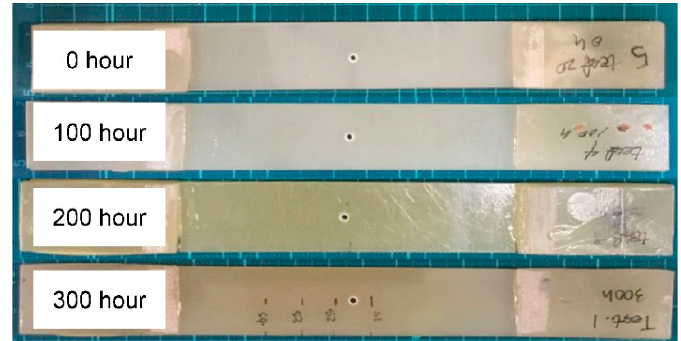
Figure 2. Schematic illustrations of GFRP specimens with a center hole and sensor locations.